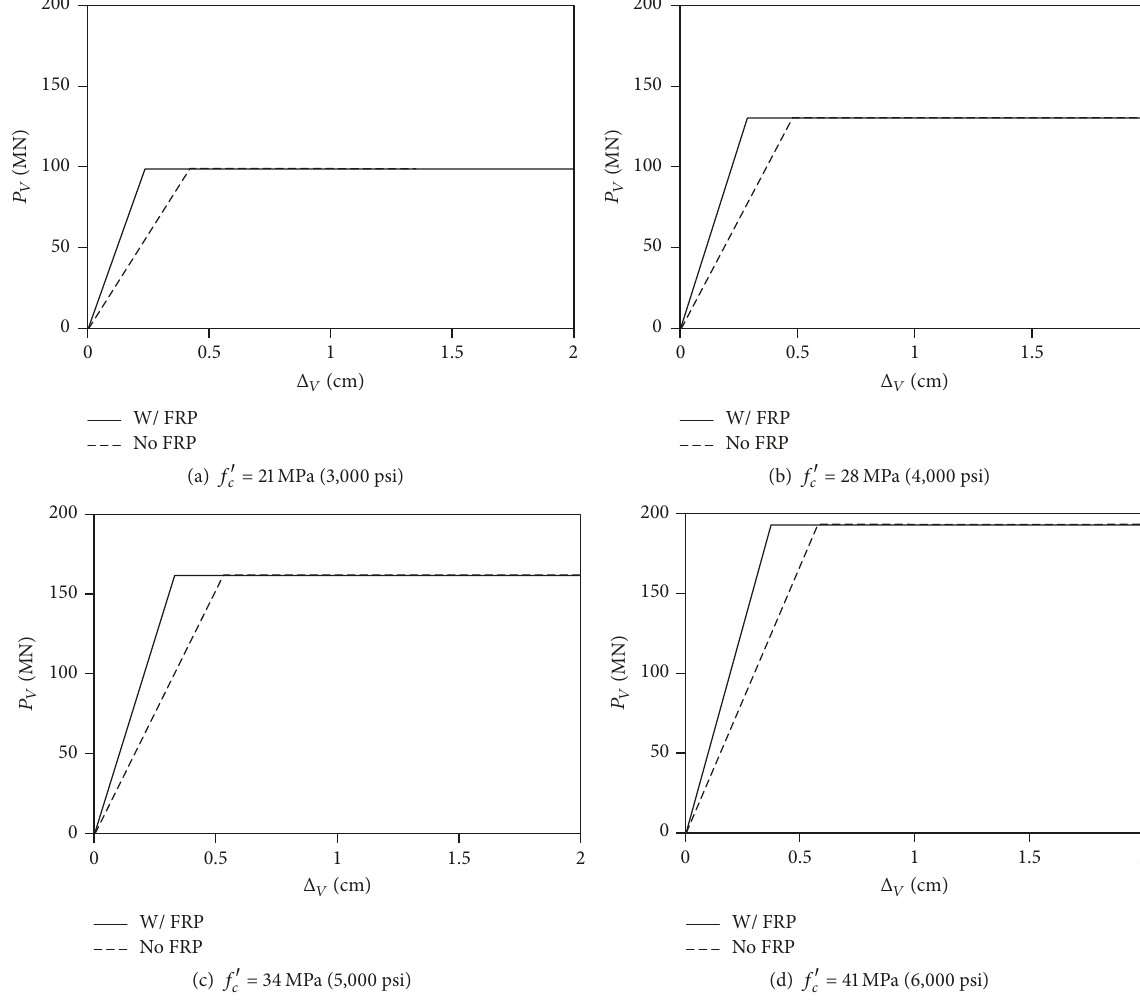
Figure 7: Pier section (1.8m by 1.8m) subjected to vertical loads (thickness of FRP wrap = 3.3